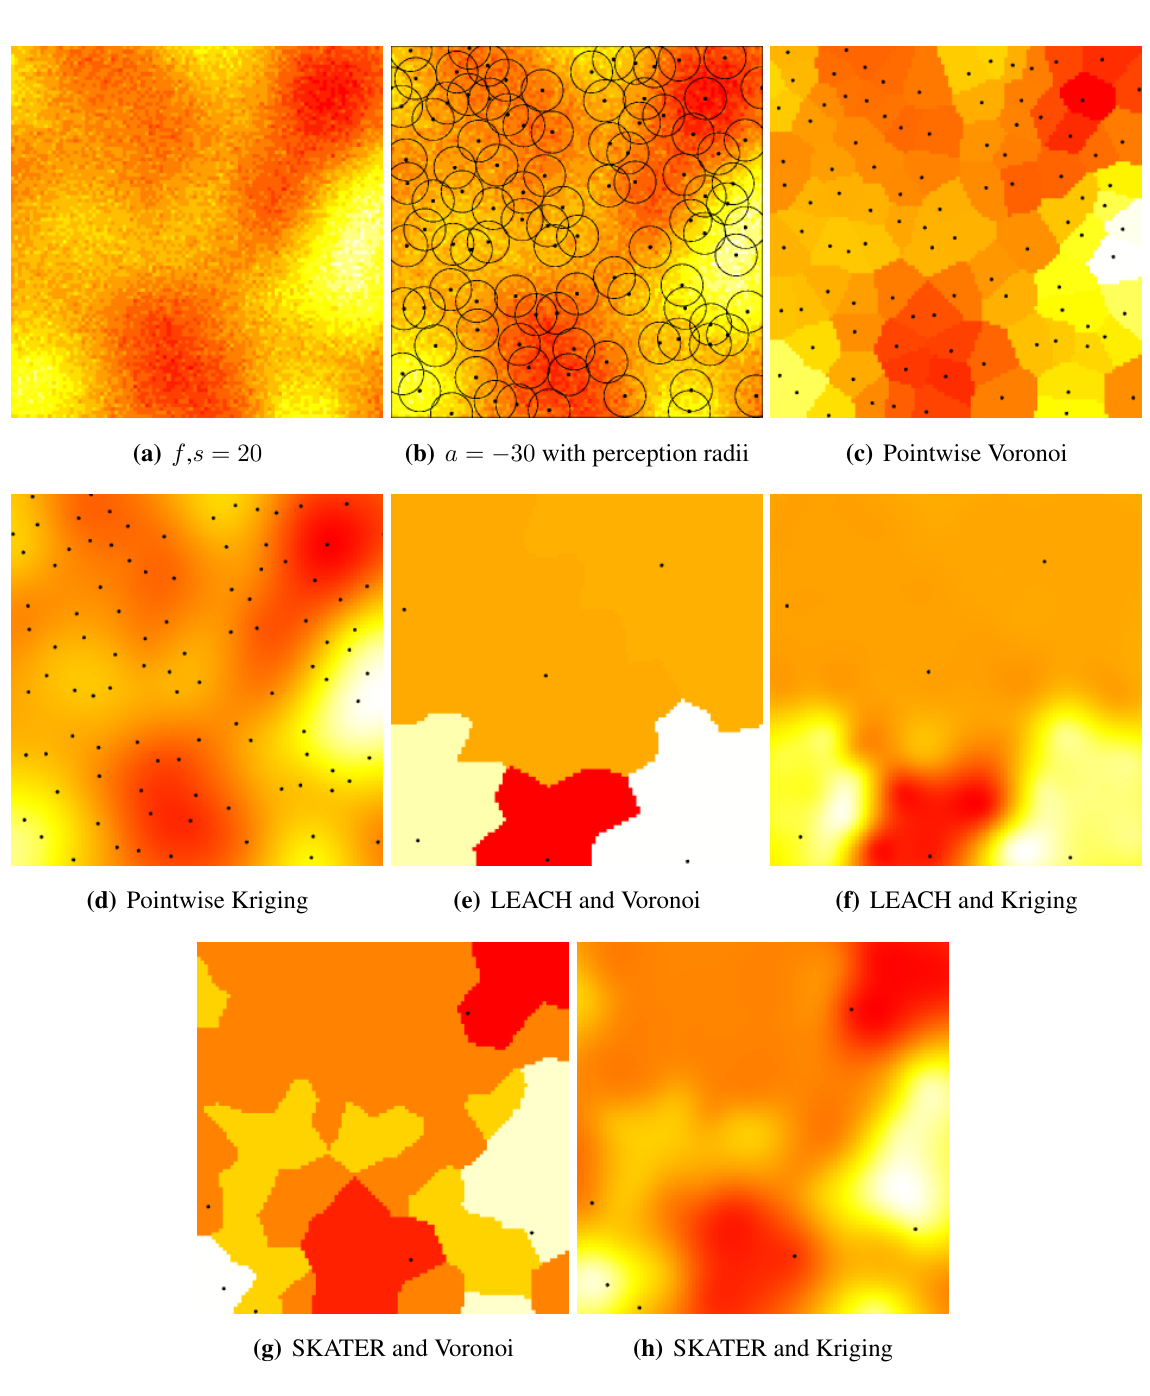
Figure 4. General setup and alternatives for clustering, aggregation and